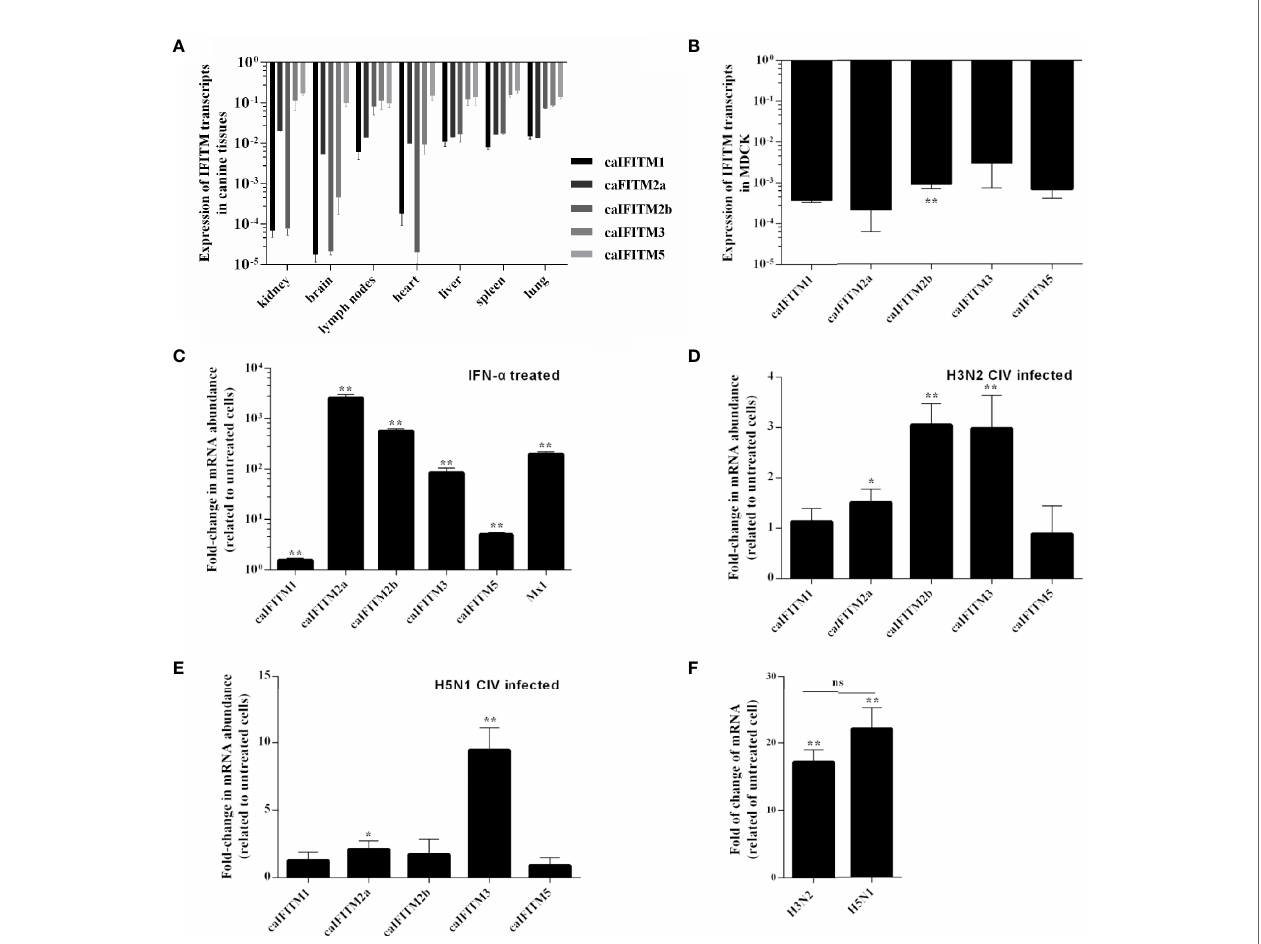
FIGURE 3 | The expression pattern of caIFITMs. (A) The expression level of caIFITMs in tissue samples from beagles. Seven tissue samples were individually collected from three 10-week-old beagles. RNA was extracted from each sample and subjected to RT-qPCR. The expression level of caIFITMs in each tissue was compared with GAPDH. (B) The expression level of caIFITMs in MDCK. RNA was extracted from cultured MDCK cells and was used for RT-qPCR. The expression level of caIFITMs was compared with GAPDH. (C) The change of expression level of caIFITMs in MDCK after treated with IFN. MDCK cells were treated with recombinant human IFN- a (10,000 U). After 24 h, both treated and untreated MDCK cells were collected, and expression level of caIFITMs was determined by RT- qPCR. The expression level of caIFITMs of cells treated with IFN was compared with that in untreated cells. Mx1 was used as control. (D, E) The change of expression level of caIFITMs in MDCK after being infected with H3N2 CIV (GD/2014) and H5N1 CIV (GD/2013). MDCK cells were infected with H3N2 CIV (GD/2014) or H5N1 CIV (GD/2013) at 0.1 MOI. At 24 hpi, cells were collected and expression level of caIFITMs was determined by RT-qPCR. The expression level of caIFITMs of cells treated with CIV was compared with that in untreated cells. Mx1 was used as control. (F) The change of expression level of canine IFN- a in MDCK after being infected with H3N2 CIV (GD/2014) and H5N1 CIV (GD/2013). Cells collected in (D, E) were processed for estimating expression level of canine IFN- a by RT- qPCR. The expression level of canine IFN- a of cells treated with H3N2/H5N1 CIV was compared with that in untreated cells. All data represent the means and SD for experiments (each repeated in triplicate) and were analyzed by Student ’ s t -test. (ns, not signi fi cant; * p < 0.05; ** p <